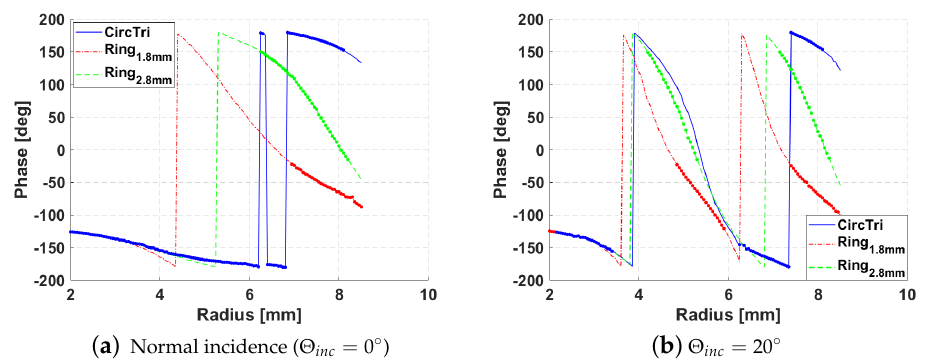
Figure 6. S-curve of selected elements for normal incidence and Θ inc = 20 ◦ , highlighting the valid ones in each case according to the maximum of the allowed